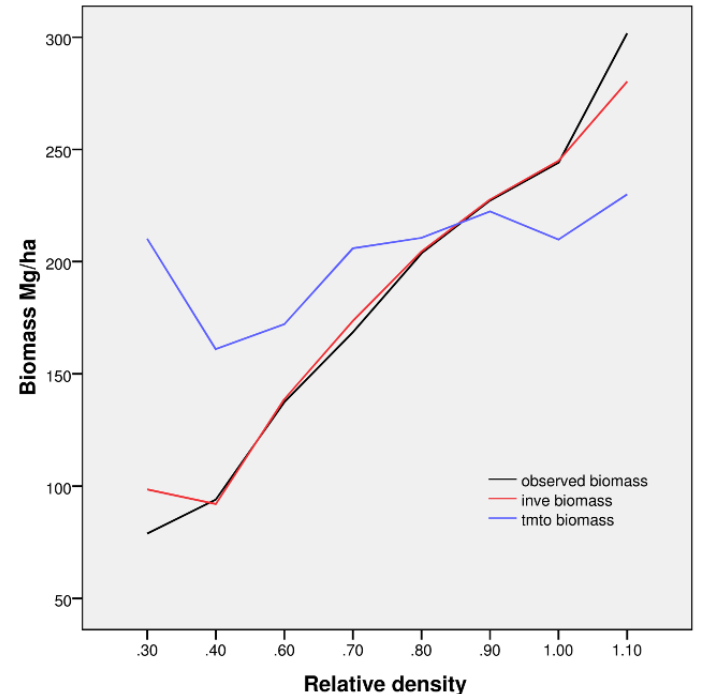
Figure 7. Relative stand density, observed biomass (black line) and predicted values of biomass for models INVE (red line) and TMTO (blue line) for all of 105 stands we sampled in summer 2006 and